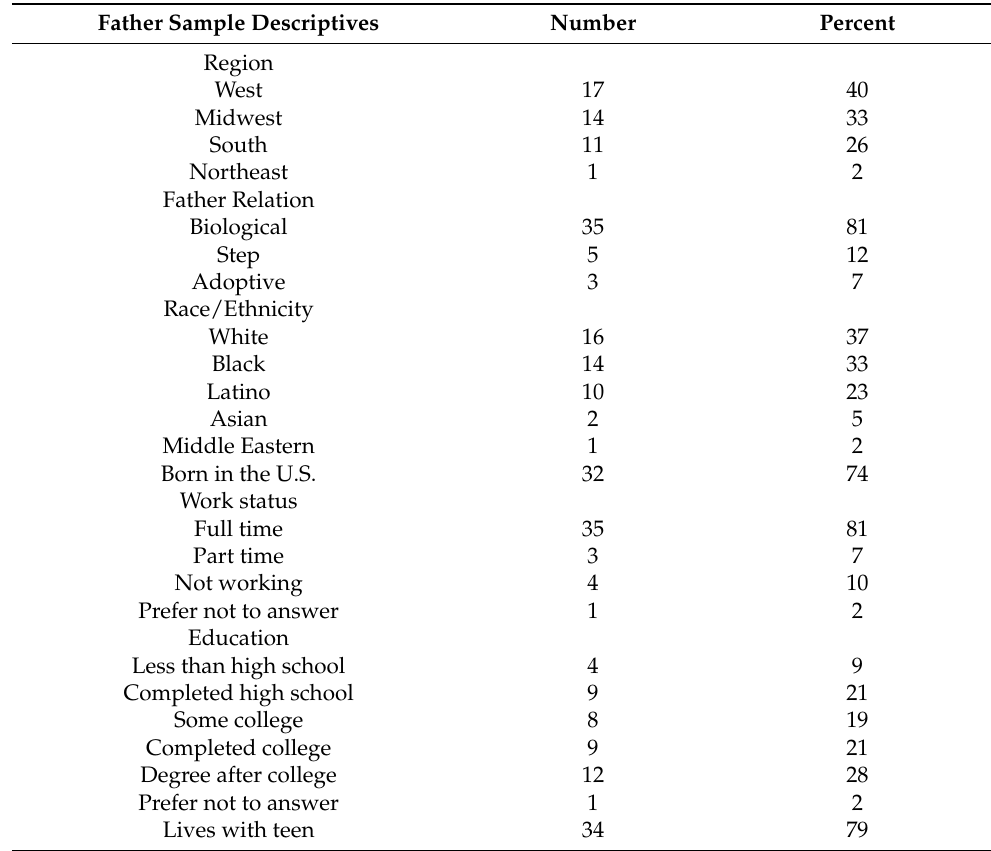
Table 1. Father sample